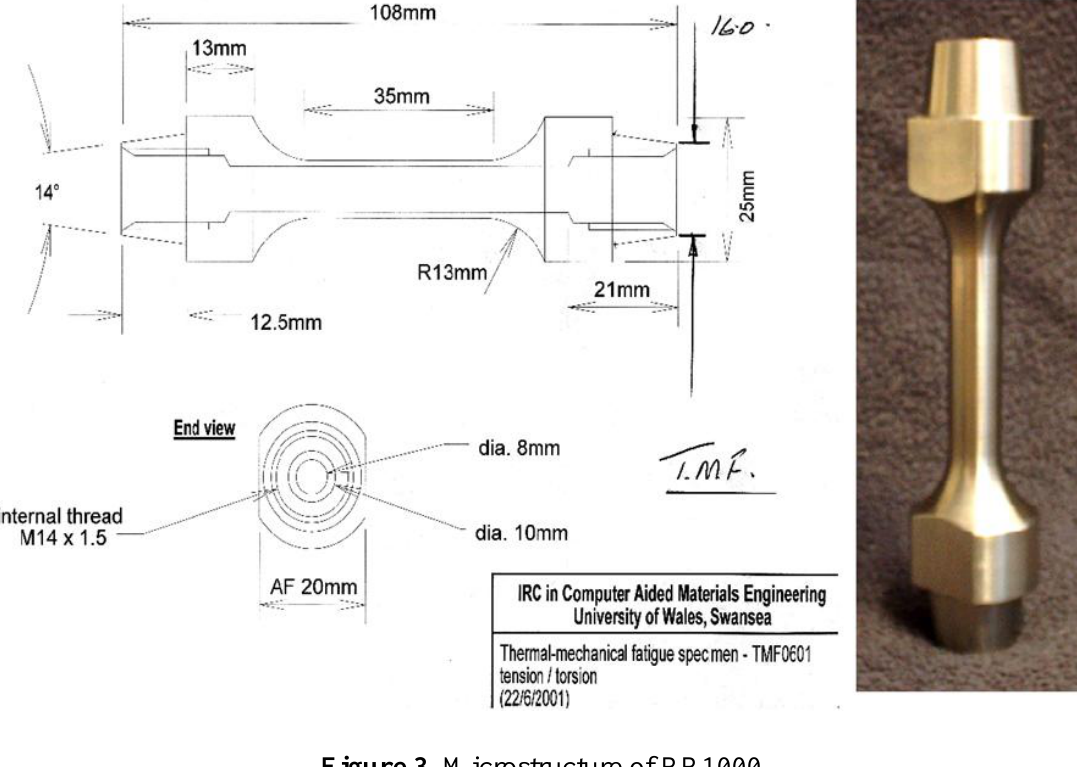
Figure 3. Microstructure of